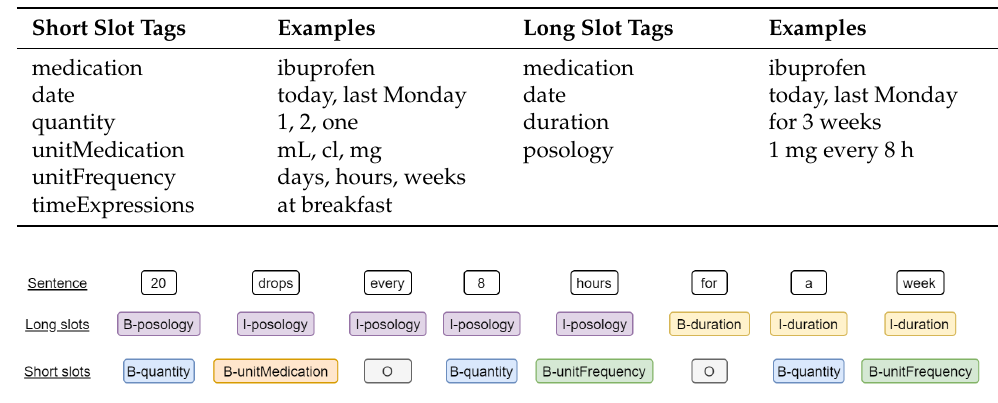
Figure 2. Example of slot filling with long and short slot configurations (using the IOB